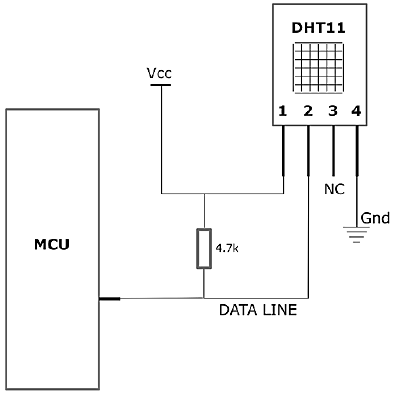
Figure 6. Connections of DHT11 with Arduino microprocessor (MCU).